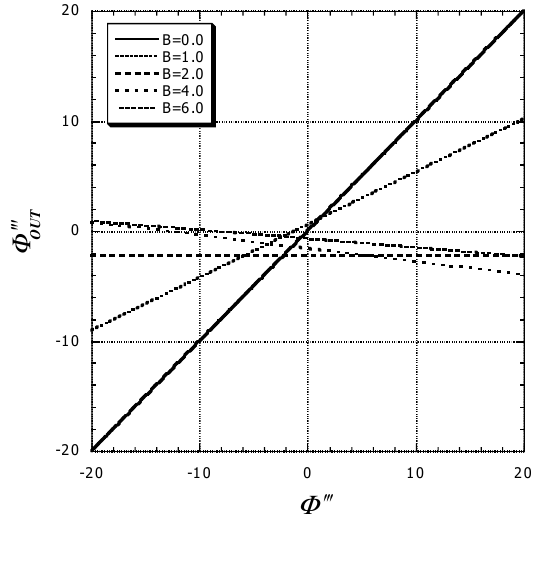
Figure 3. Same as Figure 2(c), except the effect of self-steepening is